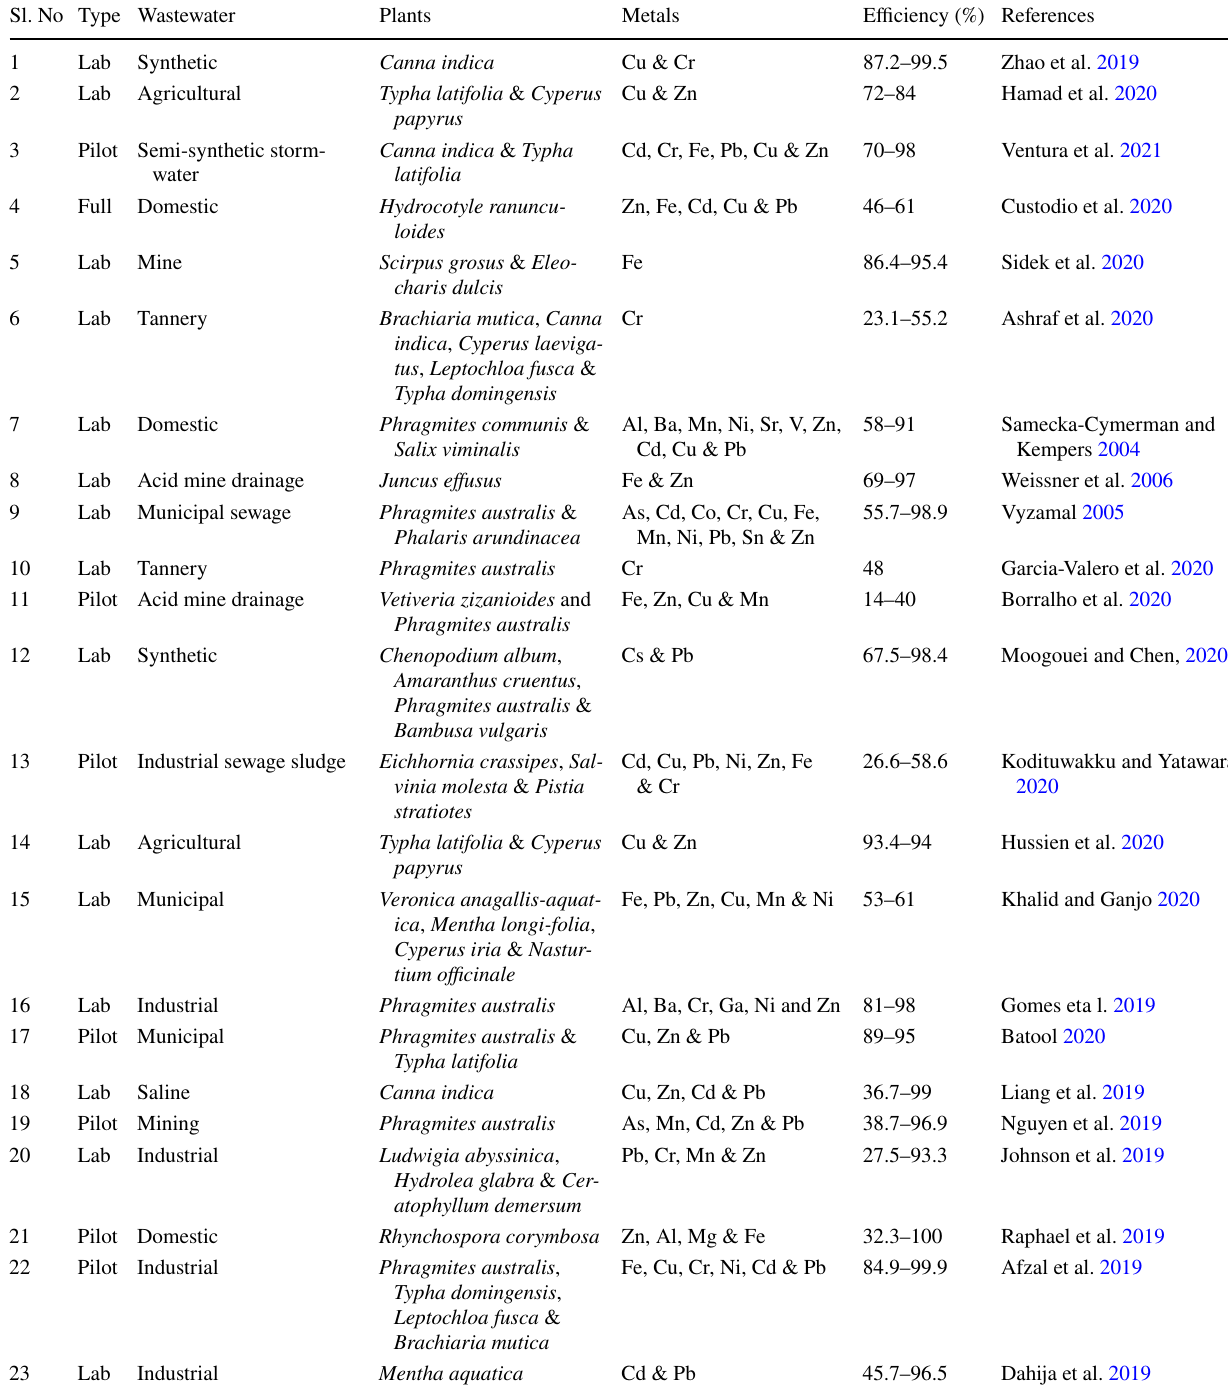
Table 3 Performance of aquatic macrophytes for metal removal in different constructed wetlands Sl. No Type Wastewater